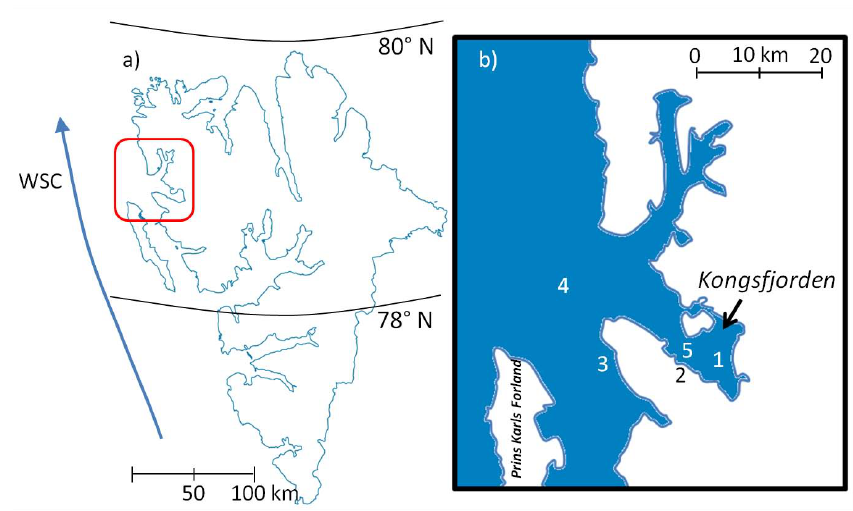
Fig. 1. (a) Overview map of the investigation area (marked red). Blue arrow indicates the direction of the West Spitsbergen Current (WSC). (b) Sampling locations. Point 1: close to the glacier Kongsbreen (summer and winter measurements); point 2: marine laboratory with deep sea water inlet in Ny- ˚Alesund (summer and winter measurements); point 3: outside of Kongsfjorden (winter measurements); point 4: outside of Kongsfjorden (summer measurements); point 5: middle of the fjord (summer measurements) (modified from Z´abori et al.,